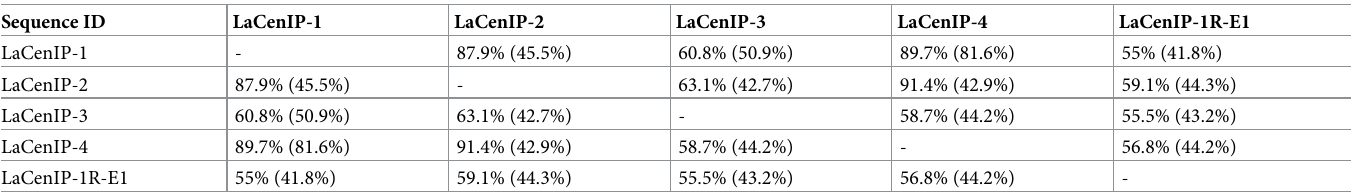
Table 1. Sequence identity of five centromere-related sequences by pair-to-pair comparison of their overlap regions and cloned full-length sequences (parentheses). Sequence